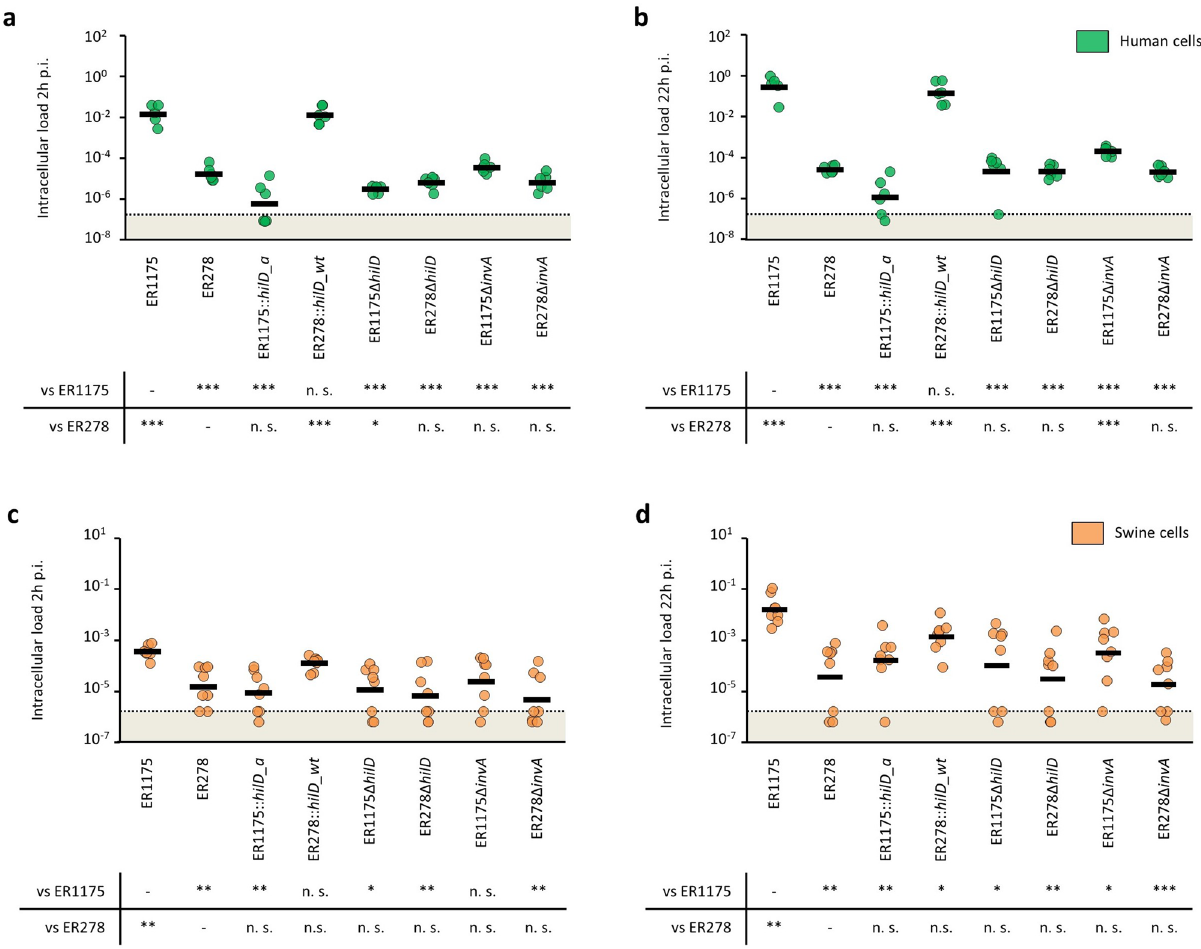
Figure 3. Role of hilD point mutation in virulence. Intracellular loads at 2 h and 22 h post infection (p.i.) of ER1175, ER278 and their mutants in human cells ( a , b ) and swine cells ( c , d ). Results are expressed as intracellular bacteria recovered after 2 h and 22 h of infection divided by the inoculum. Three biological replicates were performed in human cells, four replicates in swine cells and each tested in duplicate. Dots represent the values of the replicates. Arithmetic means are indicated by horizontal lines. Tables report p-values from two-tailed Student’s t-test corrected for multiple comparisons (*p < 0.05, **p < 0.01, ***p < 0.001, n.s. not significant). The dotted line represents the limit of